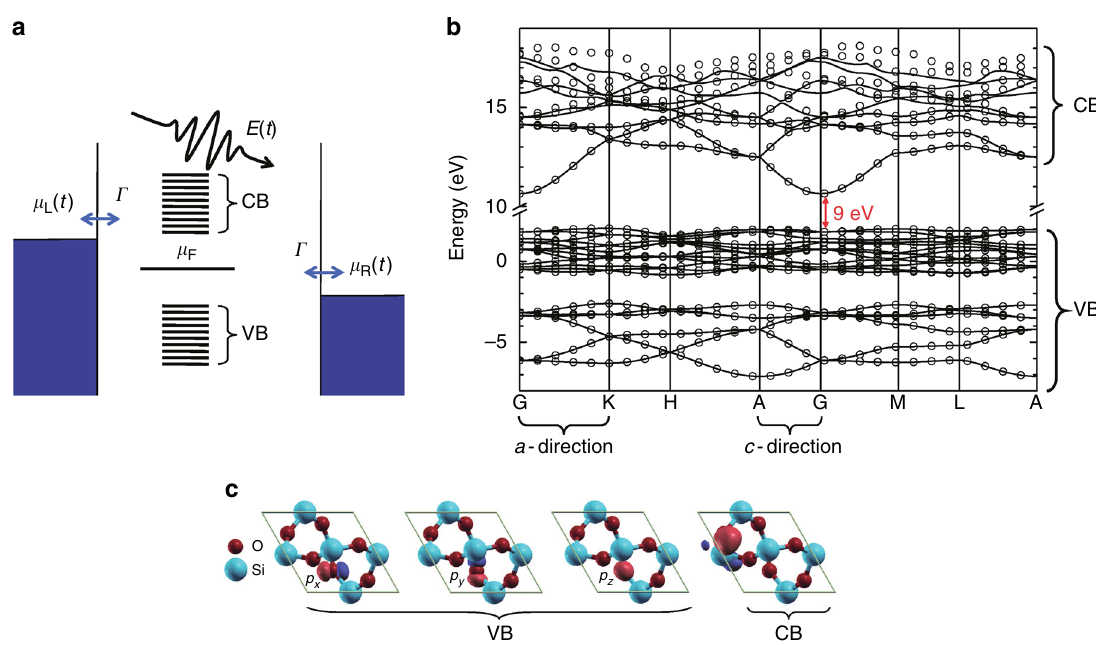
Fig. 1 Electronic structure of the gold – silica – gold nanojunctions. a Energy diagram of the nanojunction in the presence of a laser E ( t ). The junctions are composed of N unit cells of α -SiO 2 grown along the a ( E || a ) or c ( E || c ) crystallographic directions and connected by its ends to metallic contacts. The lead ’ s Fermi energy μ F is taken to be between the valence band (VB) and conduction band (CB). Here, Γ / ħ is the charge transfer rate between each Wannier functions at the terminal unit cells to the corresponding lead and μ α ( t ) the chemical potential of left ( α = L) and right ( α = R) contact. b Band structure of α -SiO 2 computed using density functional theory (solid lines) and the generalized tight-binding model (open circles) based on maximally localized Wannier functions (MLWFs). The model consists of 27 MLWFs per unit cell that result in 18 VBs and 9 CBs. It accurately reproduces the band structure in a wide energy range and the 9 eV experimental band gap. The relevant electronic structure along the a and c -direction are highlighted. c Isosurface contours of four representative MLWFs (red for positive value and blue for